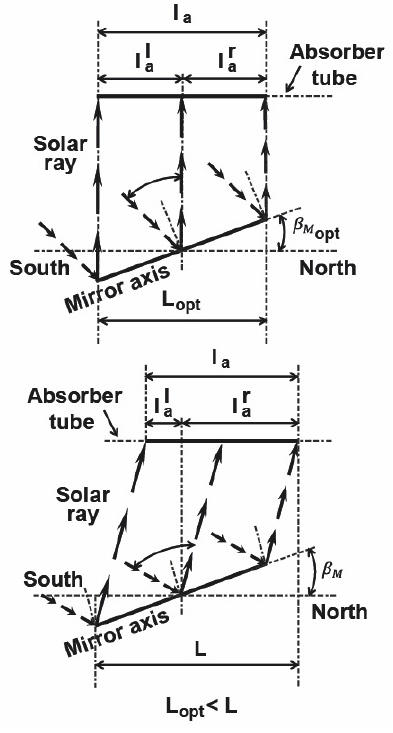
Figure 2. Influence of β M